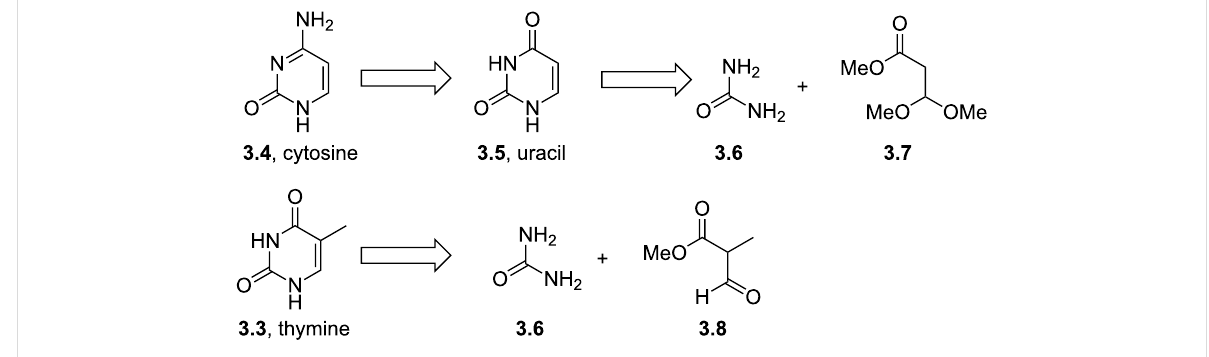
Scheme 31: Typical routes accessing uracil, thymine and cytosine.